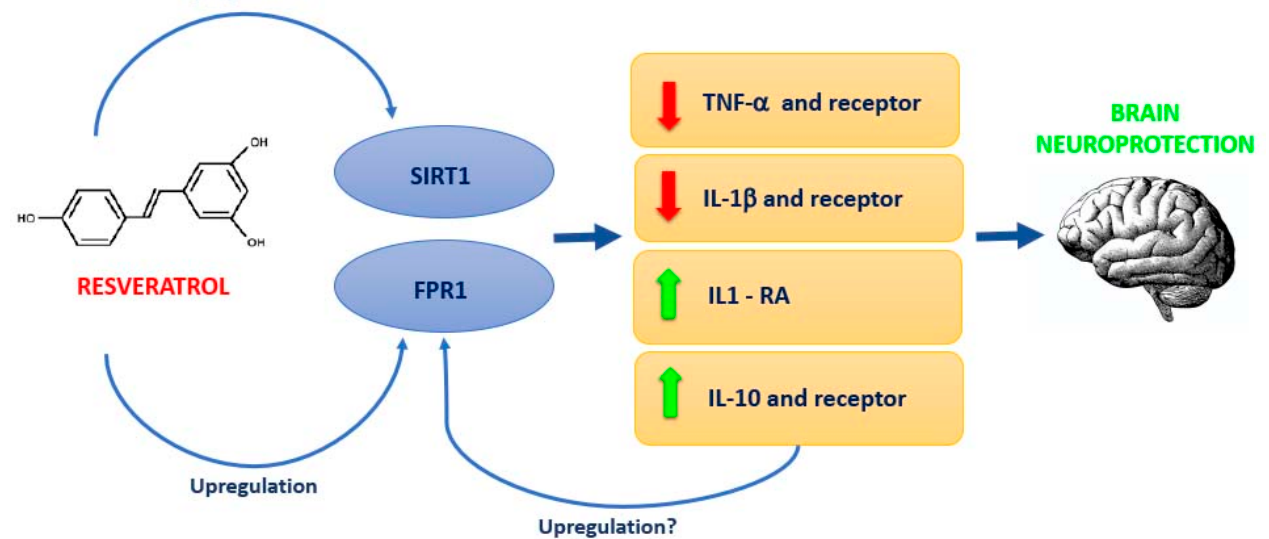
Figure 7. Schematic presentation of the possible mechanism for resveratrol neuroprotection in a mouse model of LPS- induced neuroinflammation. Resveratrol induces FPR1 and SIRT1 upregulation that could improve neuroinflammatory condition and IL-10 may be involved in the upregulation of FPR1.